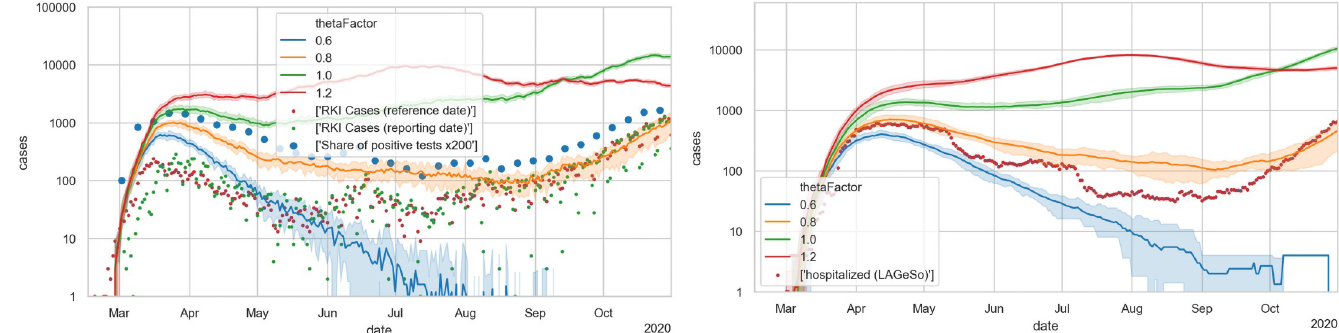
Fig 10. Simulations that now also include a symmetric indoors/outdoors model, with a threshold temperature of 17.5C both in spring and in fall. LEFT: new cases; RIGHT: hospital occupancies. A thetaFactor between 0.6 and 0.8 is most plausible, but the second wave would come too late (starting after September) and would not be steep enough (compare slope of red dots in right plot after September) (cf. in particular the hospital numbers).